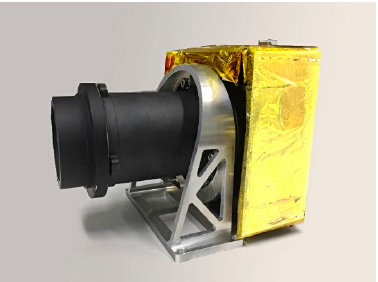
Figure 3. Nighttime light remote-sensing camera of Luojia 1-01.